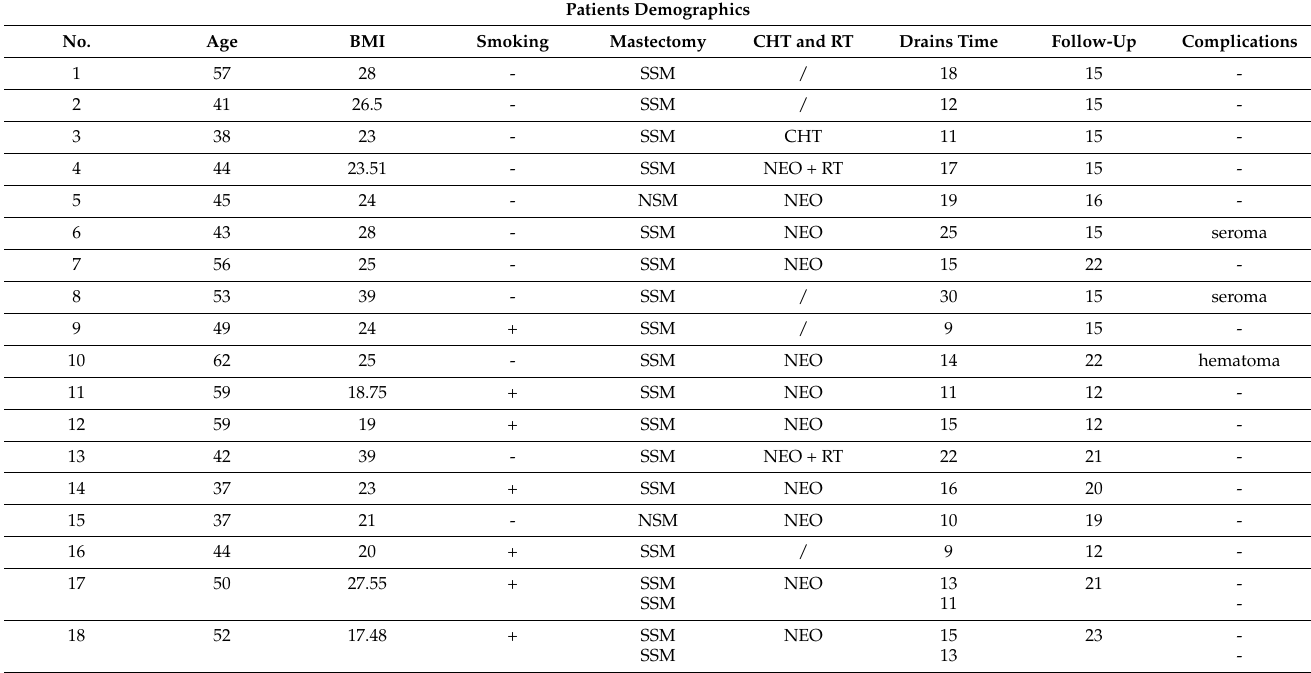
Figure 2. Example of US after breast reconstruction with a tissue expander using a muscolofascial pocket. ( a ) Thickness of the skin and subcutaneous tissue. ( b ) Total coverage thickness of the im- plant. Table 1. Patient demographics. BMI: body max index, SSM: skin sparing mastectomy, NSM: Nipple-sparing mastectomy, CHT: chemotherapy, NEO: Neoadjuvant chemotherapy, RT: radiotherapy.